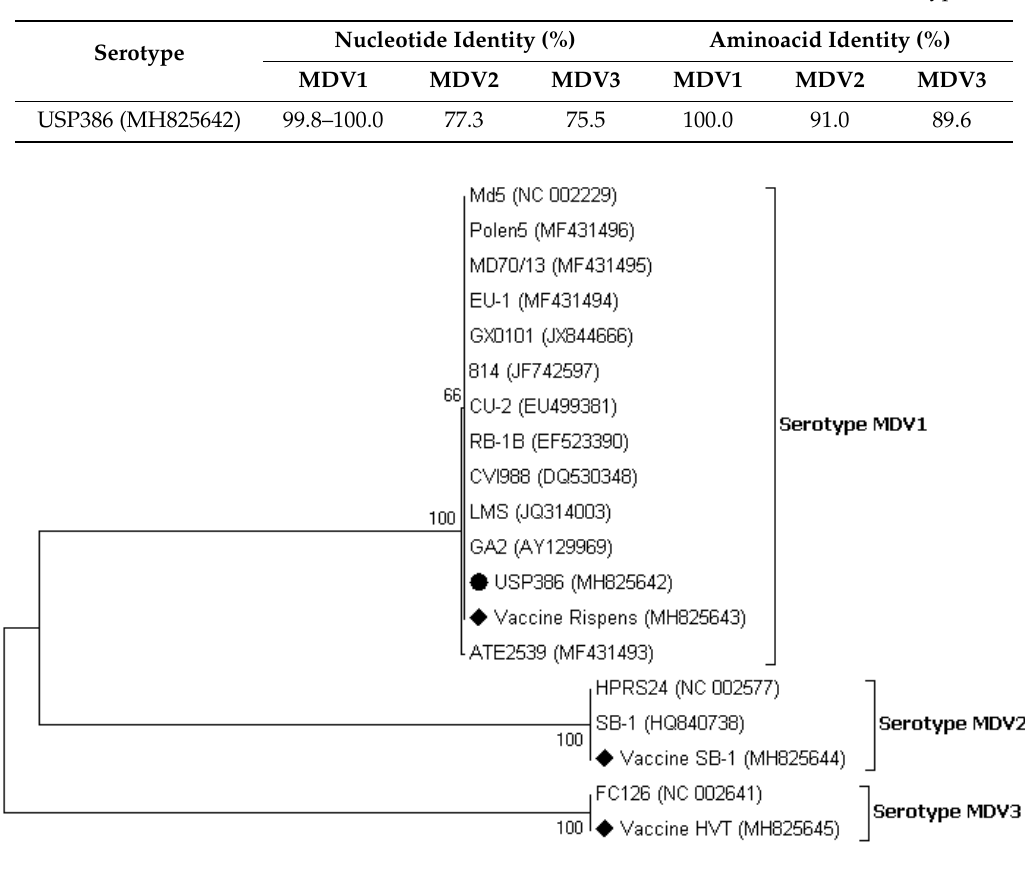
Table 5. The nucleotide and deduced amino acid identities of the USP386 and REV subtypes.